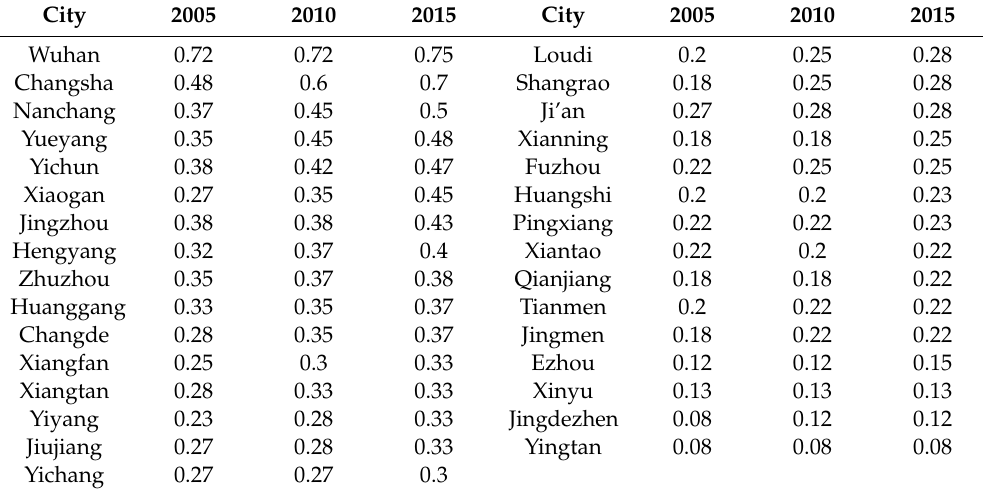
Table 2. Degree centrality of each city in the